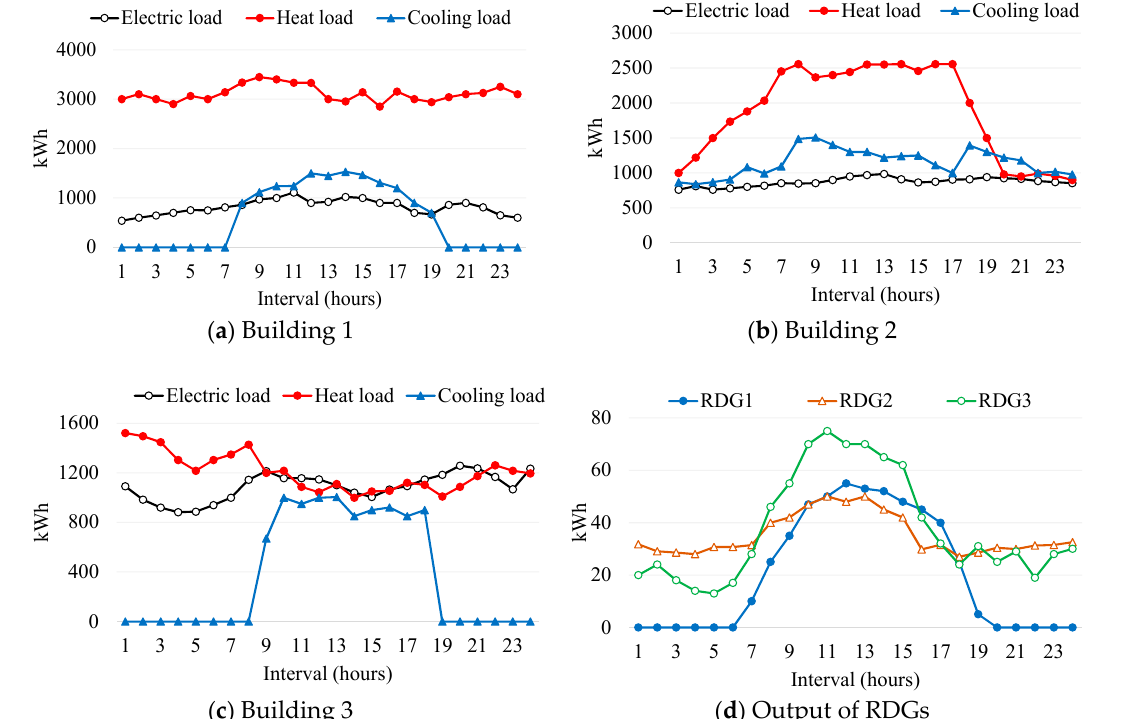
Figure 5. Load profiles and output power of RDG in each building during a weekday.